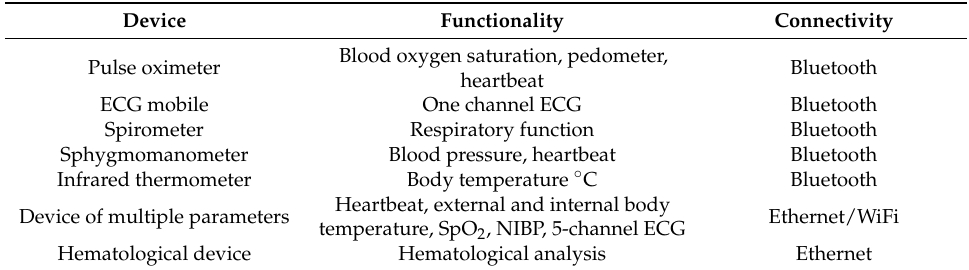
Table 2. Medical devices implemented for homecare assistance.